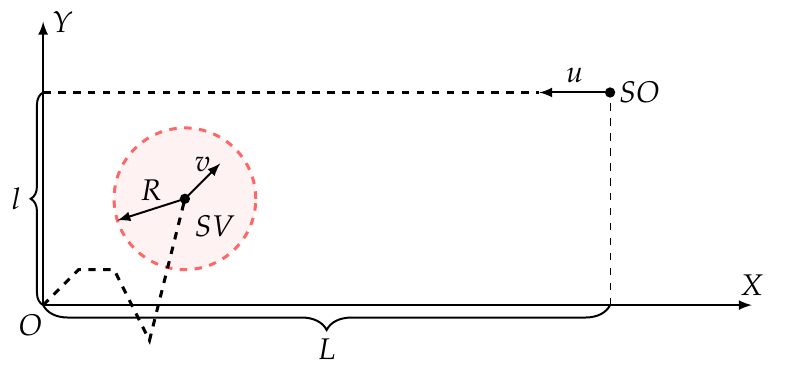
Figure 3. Relative positions of the SV and SO. Due to the latter assumption, the SV’s detection zone can be considered as a flat-line segment with the length of the diameter instead of the circle. Thus, the detection probability can be estimated as the probability of meeting the target with this segment. The histograms of the distribution density of the y SV coordinate obtained in the ∆ l , l + ∆ l ] for some small ∆ l are well approximated by the symmetric density interval [ l − of the Gaussian distribution. Figure 4 depicts the histogram of the probability of meeting between the target and SV and the corresponding density of the Gaussian distributions: ( 0, σ 2 ) for σ = 0.705 for the case L = L = 5 (Figure 4a) and ( 0, σ 2 ) for σ = 0.993 for 2 1 1 2 1 N N the case L = L 2 = 10 (Figure 4b). The histograms were constructed as a result of computer simulation of the movement of the target and SV for 10,000 implementations of the SV trajectory corresponding to λ = 5/3.